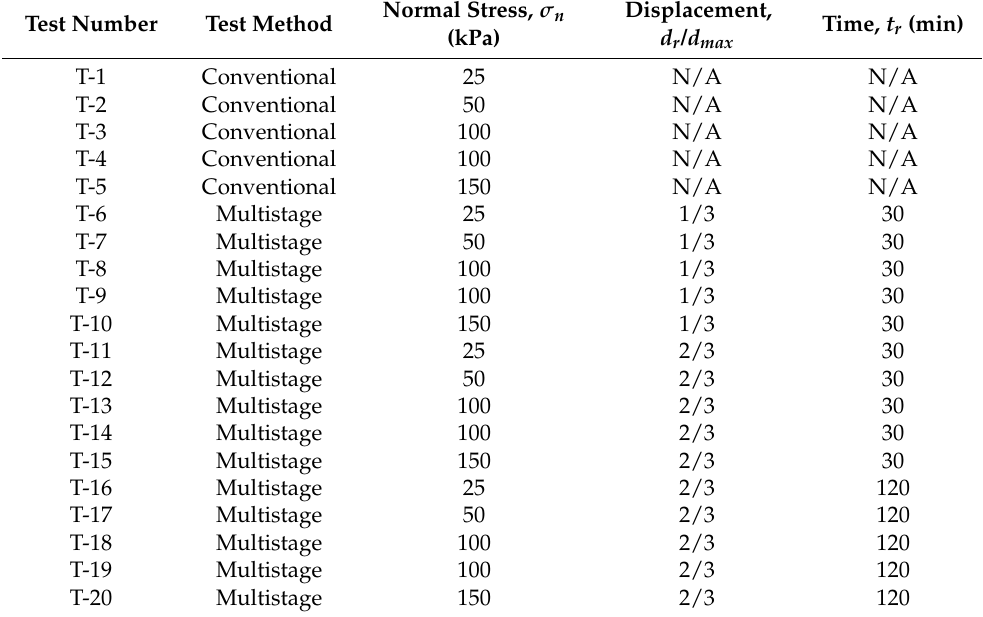
Table 4. Direct shear test